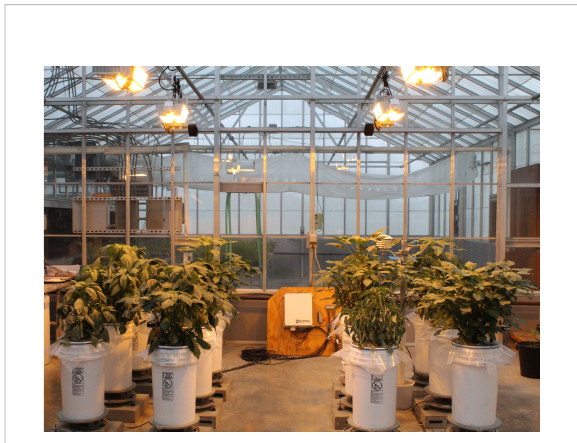
FIGURE 2 Soil waterretention curve for the silt loamsoil usedin this study. Different markers represent observations for the three undisturbed soil samples and the solid line represents the fi tted van Genucthen model. MAE is the mean absolute error of the fi tted